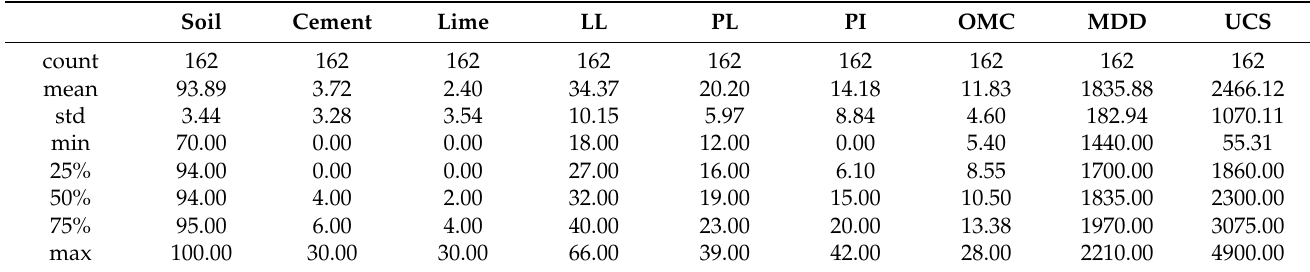
Table 2. Descriptive statistics of the